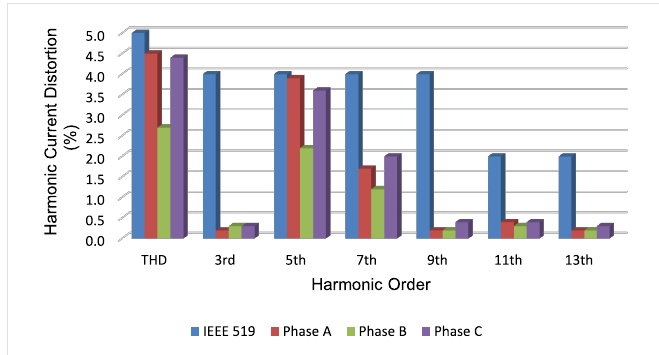
Figure 14. Three-phase grid current harmonic profile with the DHPF-NSI enabled.